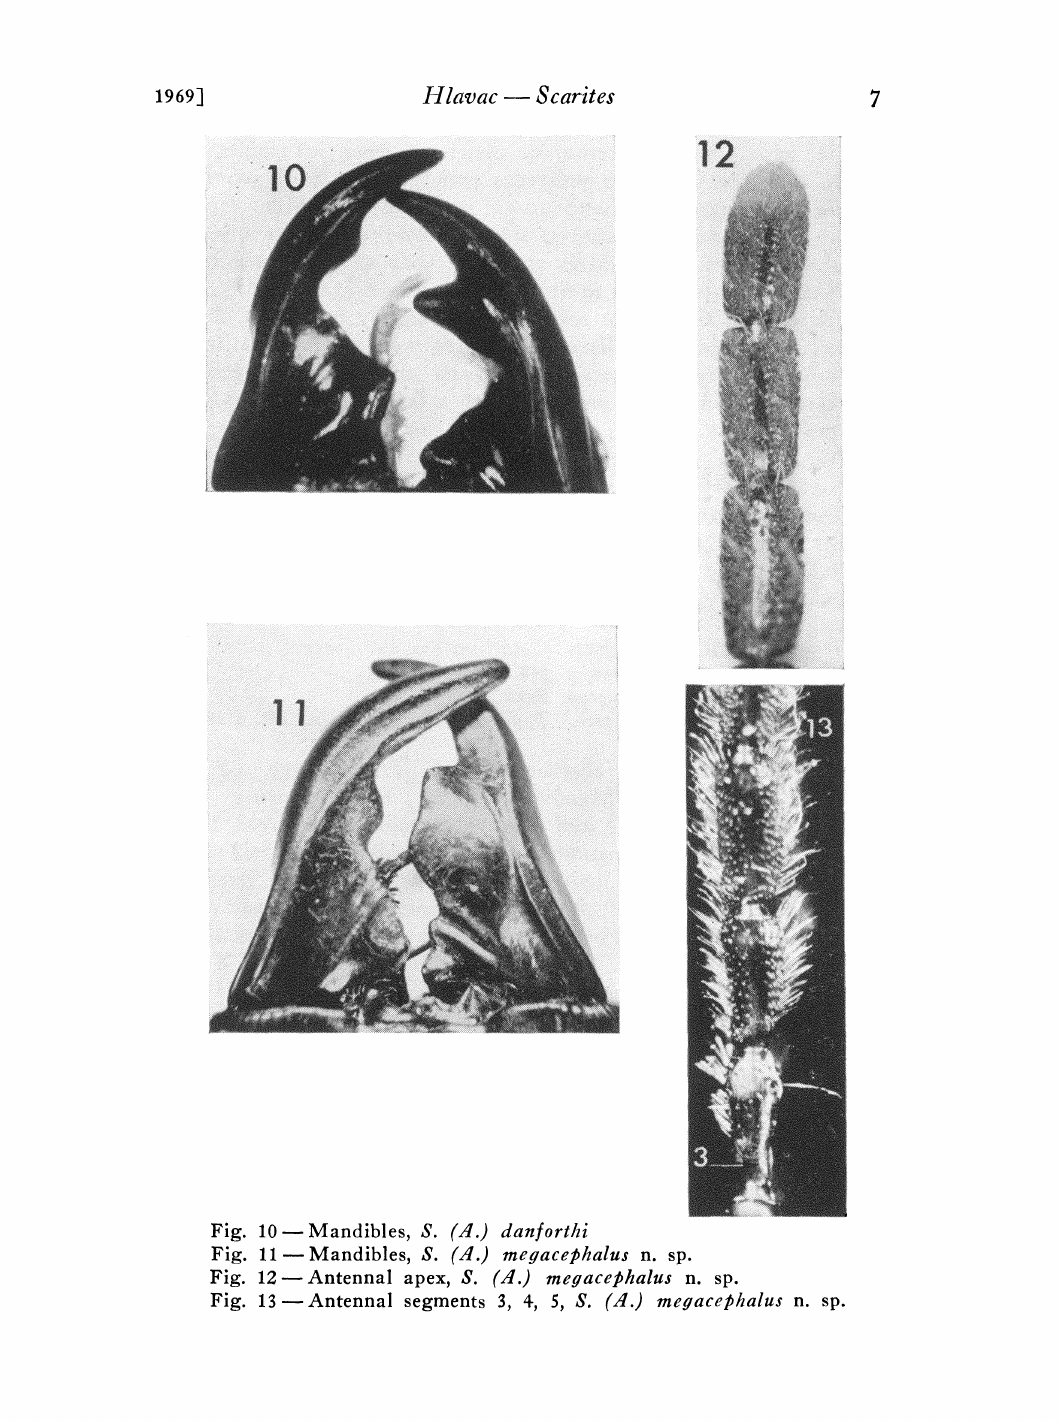
Fig. 10--Mandibles, S. (/1.) danforthi Fig. 11 Mandibles, S. (Zl.) metTacephalus n. sp. Fig. 12 Antennal apex, ,7. (/1.) metTacephalus n. sp. Fig. 13Antennal segments 3, 4, 5, 7. (Zl.) megacephalus n.